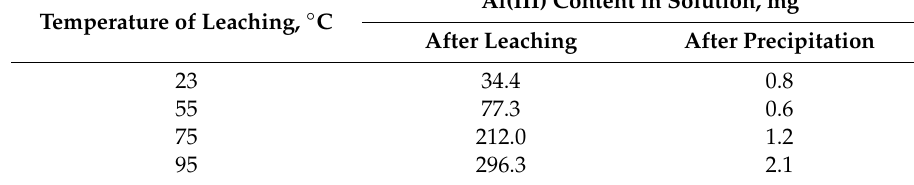
Table 3. Al(III) content in solution after leaching with 0.5 M H 2 SO 4 and after precipitation with 30% NaOH.